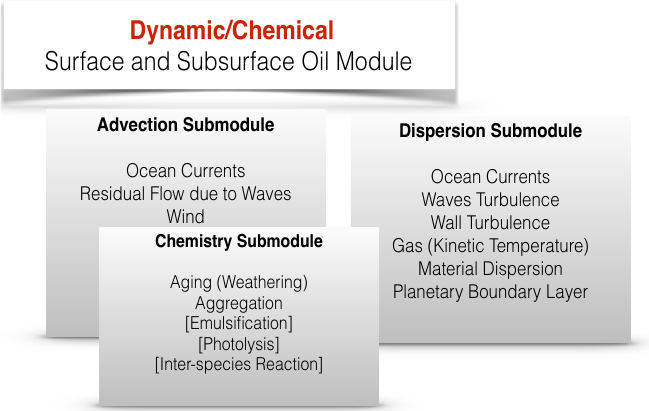
Figure 1. Advection and dispersion aspects of the model that are implemented in these modules are examined in detail in this study. Brackets indicate that a suitable empirical representation of the phenomenon would be used to capture these in the fully developed model. The ocean, atmosphere, and waves are captured by existing, supported circulation models. See Figures 2 and